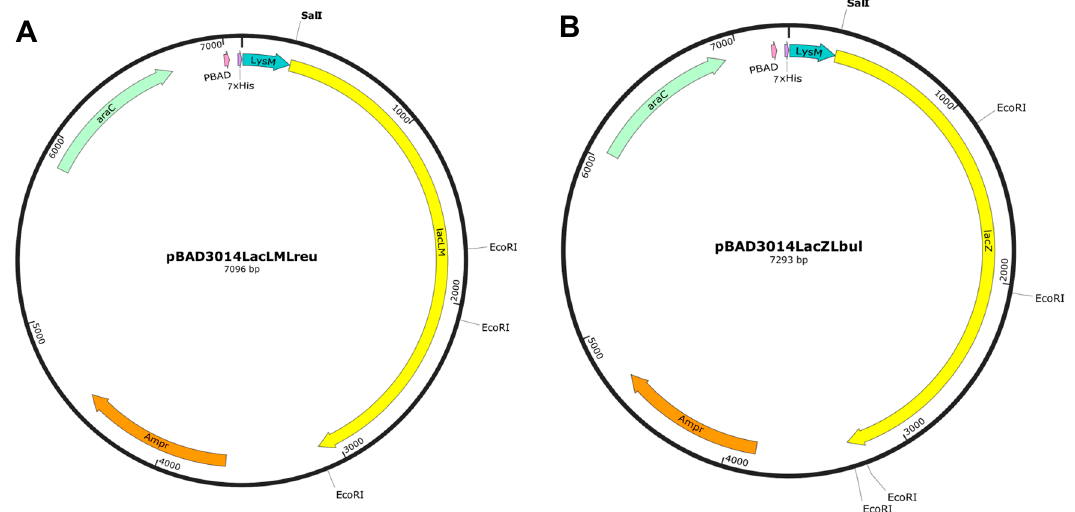
Figure 1. The expression vectors for LysM-LacLMLreu ( A ) and LysM-LacZLbul ( B ) in E. coli . The vectors are the derivatives of the pBAD vector (Invitrogen, Carlsbad, CA, USA) containing a 7 × His tag sequence fused to a single LysM domain from Lp_3014, L. plantarum WCFS1. LacLMLreu encoded by two overlapping genes lacLM and LacZLbul encoded by the lacZ gene are the β -galactosidases from L. reuteri and L. delbrueckii subsp. bulgaricus DSM 20081, respectively. See text for more details.